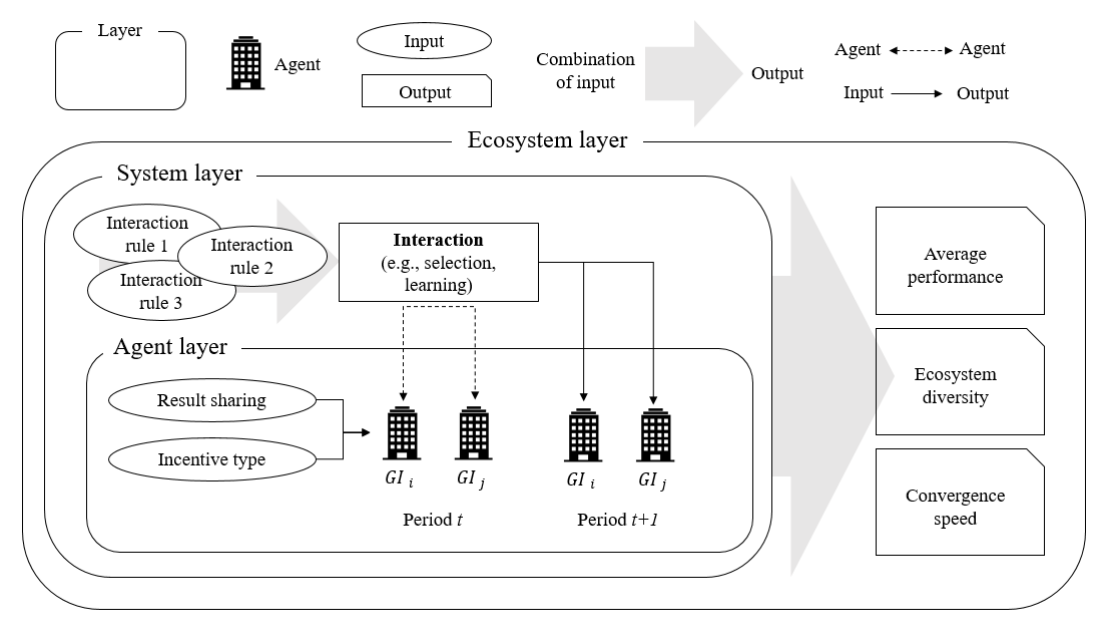
Figure 2. Description of the research model.